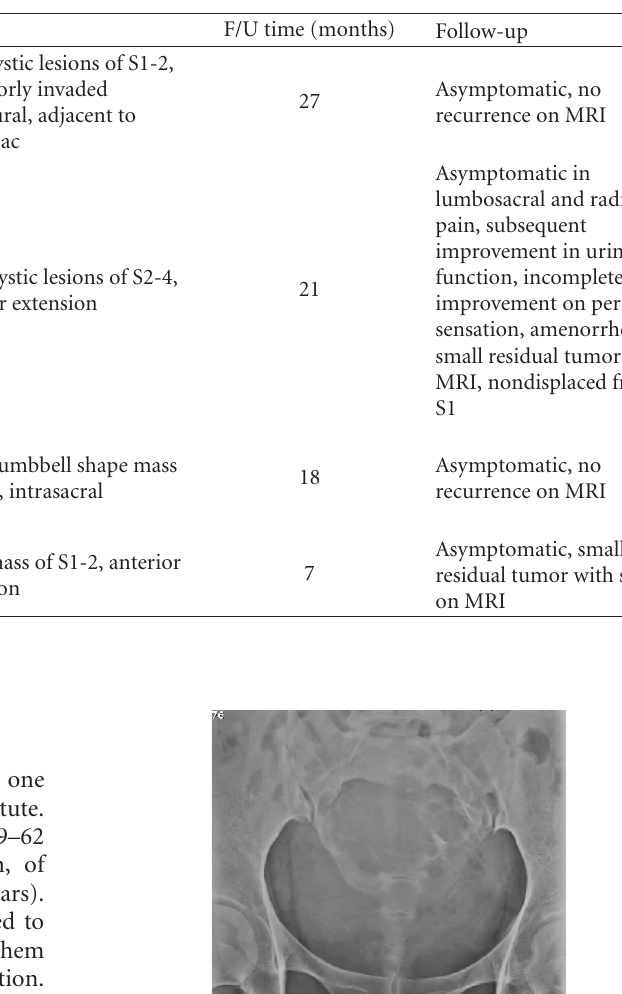
Table 1: Clinical Summary of the patients.